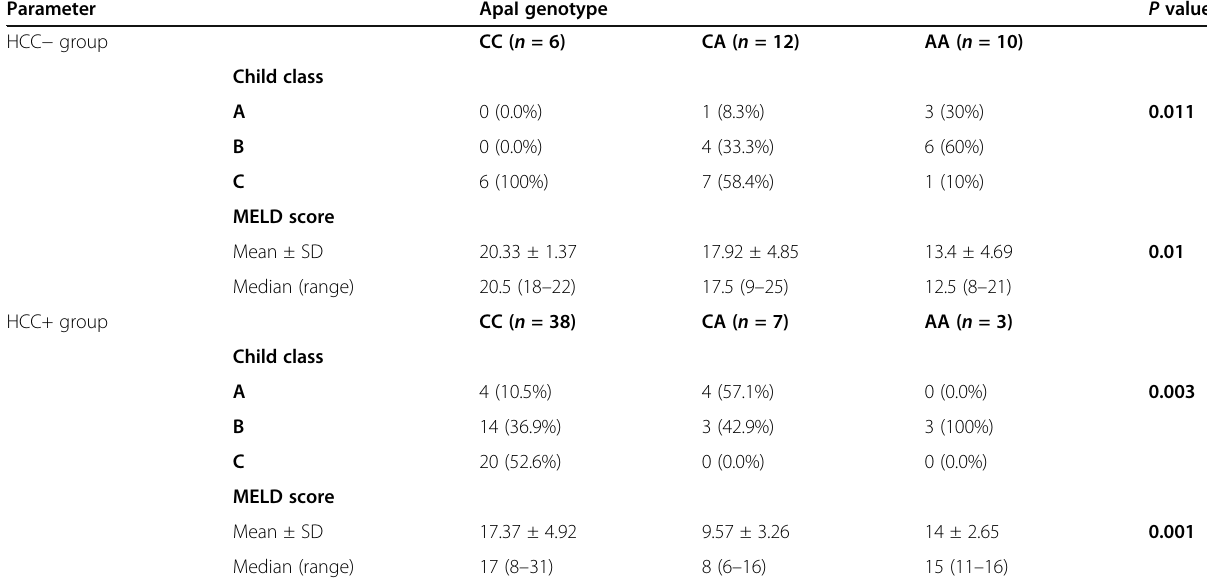
Table 4 Relationship between the individual ApaI genotypes and severity of liver disease among the two groups Parameter ApaI genotype P value HCC −